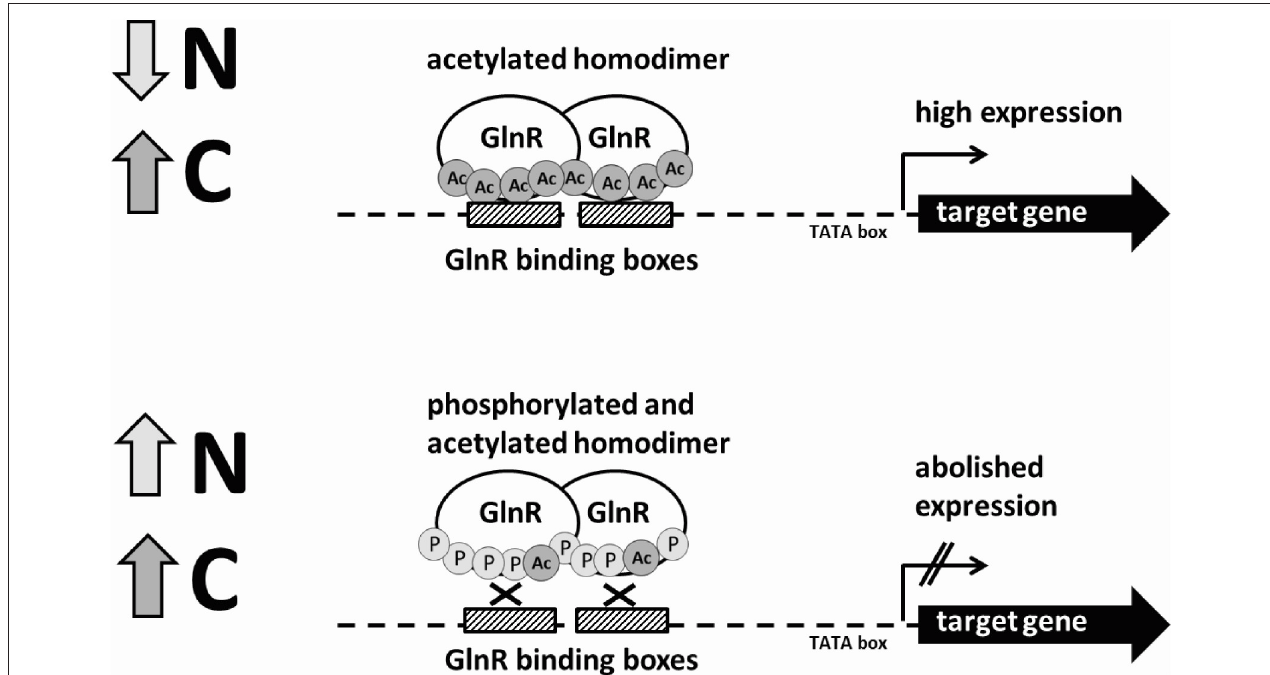
FIGURE 5 | Schematic model of the regulation of the GlnR-target genes under N- rich and N- limited conditions by the differentially modified GlnR regulator.